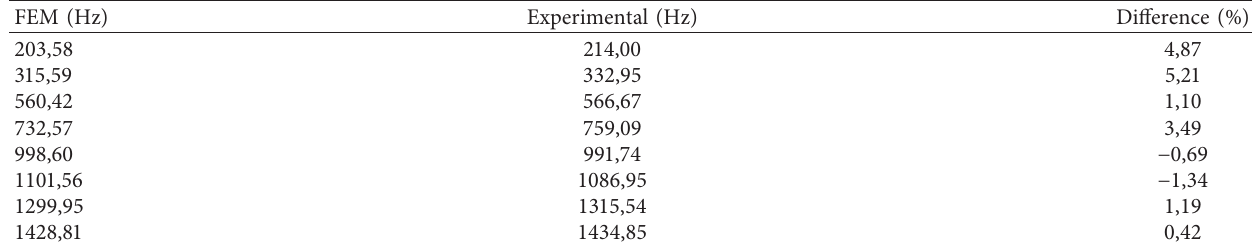
Table 6: Comparison of numerical and experimental frequencies (Case 1).